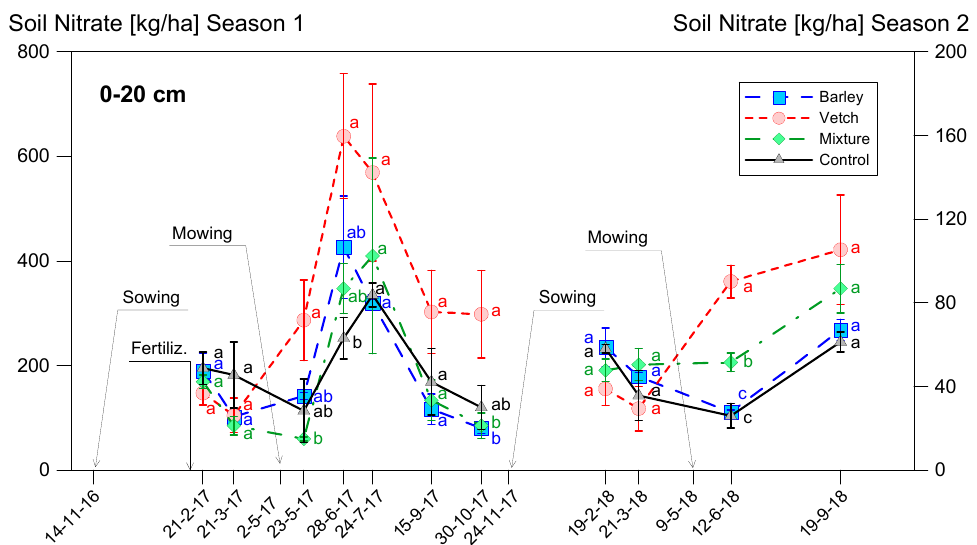
Figure 6. Soil nitrate content at 0–20 cm soil depth during the two-monitoring seasons. Vertical bars represent standard error. Different letters in each measuring date are statically different based on the LSD test ( p ≤ 0.05). X units follows the format DD-MM-YY.